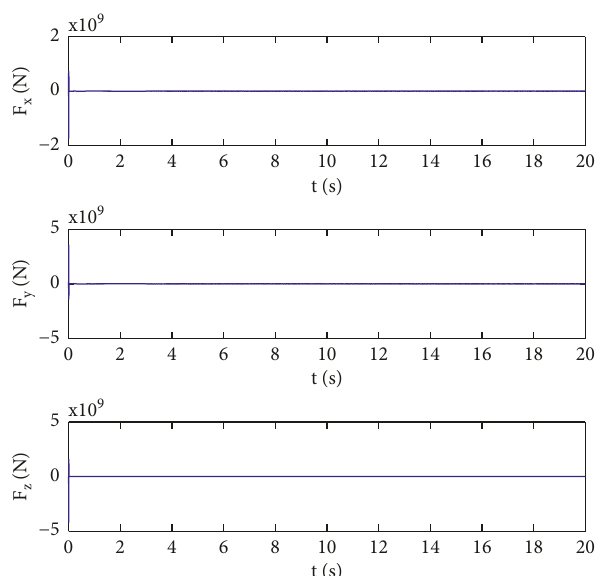
Figure 6: Input signals of the proposed controller.